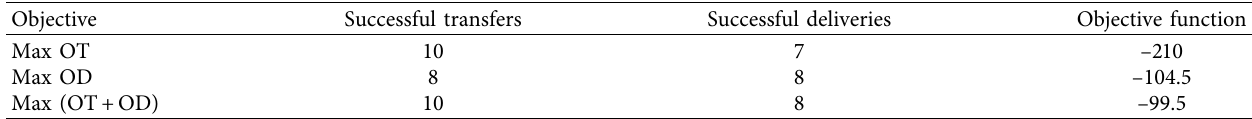
Table 5: Results of different